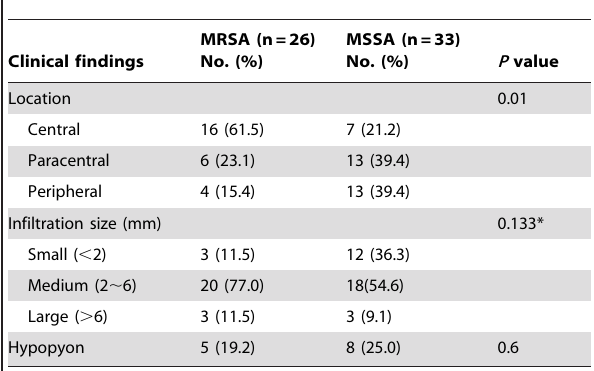
Table 4. Antibiotics susceptibility of MRSA and MSSA isolates for